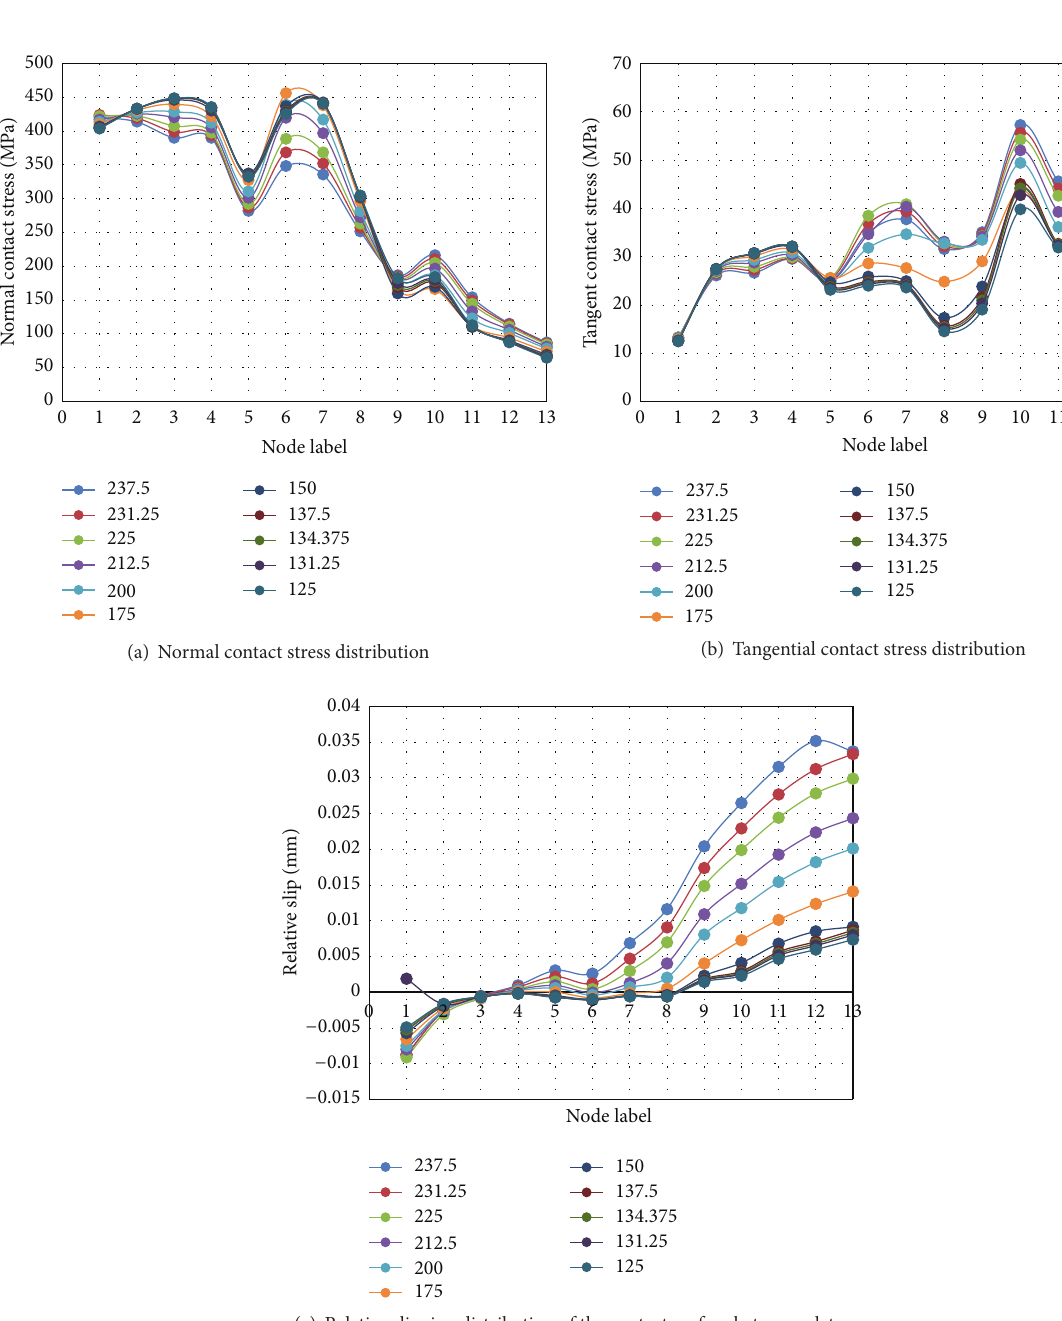
(c) Relative slipping distribution of the contact surface between plates Figure 9: Distribution of normal stress and tangential contact stress and slipping at different